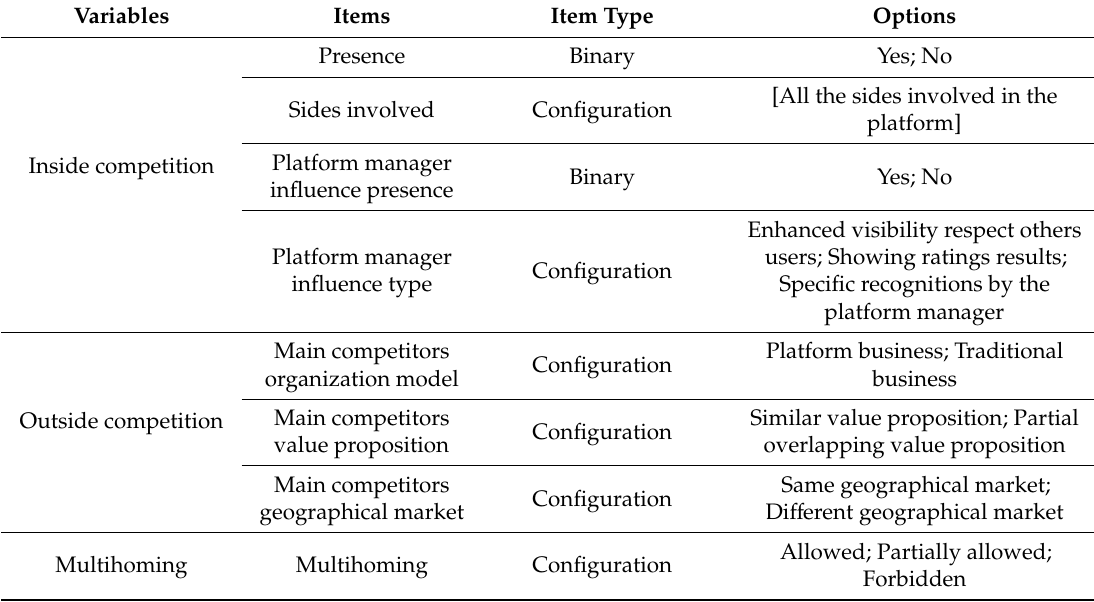
Table 9. Variables, items and configuration options for the “platform competition”